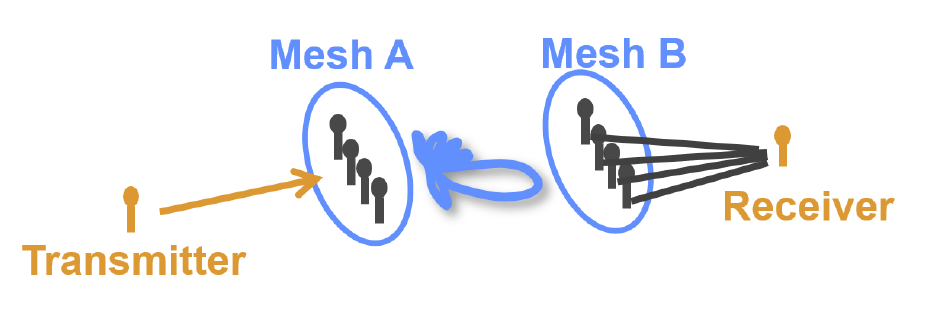
Figure 10. Distributed mesh relay network with 4 distributed radios in each mesh A and B . These mesh relays execute a distributed, multi-stage beamforming algorithm to relay a message between the transmitter and receiver.